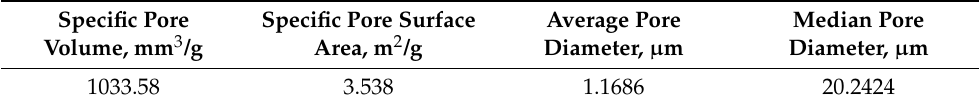
Figure 4. ( a ) Pore diameter distribution in the PLGA scaffold volume (blue line—curve of mercury intrusion into the sample volume at pressure ranging from 0 to 30 MPa); ( b ) distribution of specific surface area by pore sizes. Table 2. Porosity data of polylactic-co-glycolic acid (PLGA)